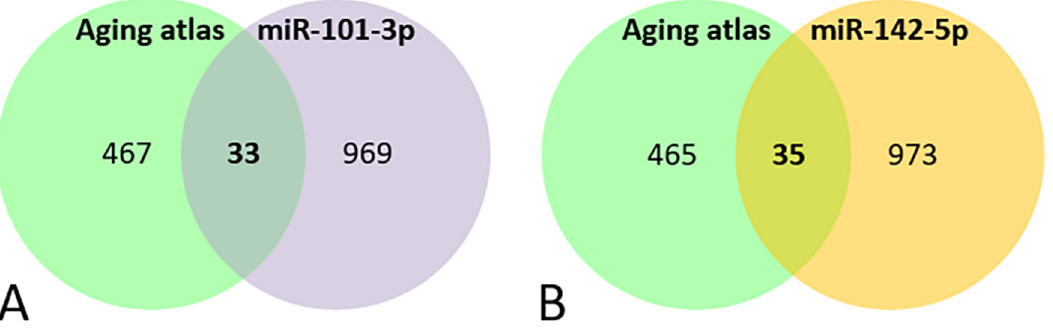
Figure 3. Venn diagram of the genes present in the aging databases and the target predicted for miR-101-3p ( A ) and miR-142-5p ( B ). Table 4. The table reports the miR-101-3p and miR-142-5p target genes that are in common with the aging atlas database. ( A ) Common miRNAs between miR-101-3p targets and those present in the aging atlas database. ( B ) Common miRNAs between miR-142-5p targets and those present in the aging atlas database. ( C ) Common miRNAs between miR-101-3p and miR-142-5p target genes and those present in the aging atlas